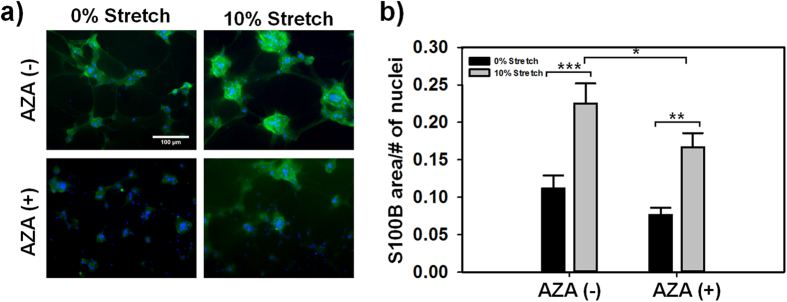
Analysis of S100B expression.(a) Representative immunostains of S100B expression. (b) Semi-quantitative analysis of S100B immunostains (*p = 0.028, **p = 0.004, ***p < 0.001; n > 18 cells from three separate experiments).